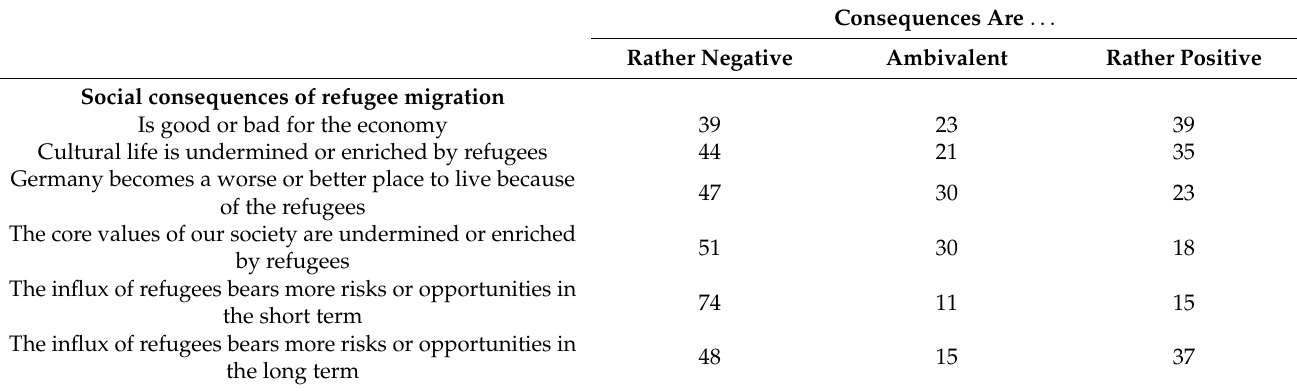
Table 5. Assessment of the consequences of refugee migration (%). Source from Jürgen Gerhards et al., German public opinion on admitting refugees , 25 May 2016, table made by authors. Consequences Are . .